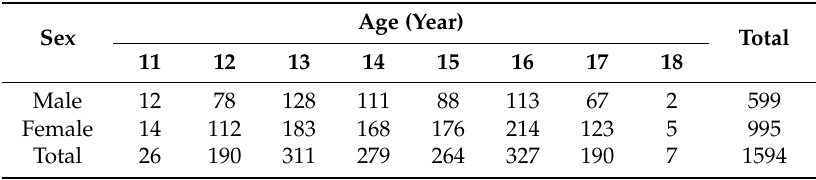
Table 2. The distribution of respondents based on their age and sex.